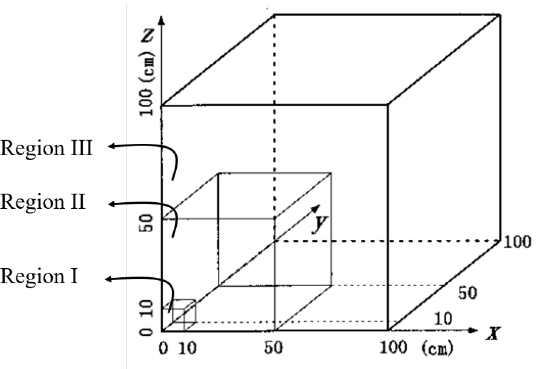
Figure 4: Geometry of the benchmark used.